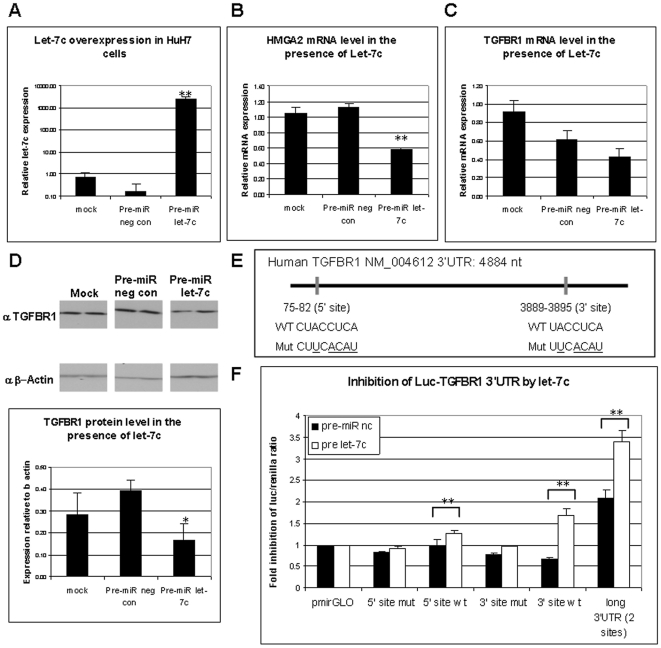
TGFBR1 is a direct target of hsa-let-7c.A. QRT-PCR results of hsa-let-7c expression level in mock transfected HuH7 cells or cells transfected with 30 nM of pre-miR negative control #1 (neg con) or pre-miR let-7c for 48 hrs. B–C. QRT-PCR results of mRNA level of HMGA2 (B) and TGFBR1 (C) in HuH7 cells transfected as described in A. D. Western blot analysis of TGFBR1 protein level in HuH7 cells transfected as described in A for 72 hrs. Quantification of the bands' intensity is shown below. E. Schematic of the 3′UTR of human TGFBR1 with the location and sequence of the 5′ and 3′ putative let-7c binding sites. The 3′UTR fragments that were cloned in pmirGLO are illustrated below. The mutations which were incorporated in the control vectors are underlined below the wt sequences. F. Luciferase/Renilla ratio results for HuH7 cells co-transfected with 7.5 nM of pre-miR negative control (nc) or pre-miR let-7c together with pmirGLO or pmirGLO-TGFBR1 3′UTR 5′ site (wt or mutant) or pGL3-TGFBR1-3′UTR 3′ site (wt or mutant) or pmirGLO-TGFBR1 long genomic 3′UTR (containing both sites), for 72 hrs. Renilla expression from the pmirGLO vector was used for Luc/Renilla ratio quantification. The results are presented as fold-inhibition relative to cells transfected with pmirGLO together with the corresponding pre-miR (nc or let-7c). In all histograms, the average of at least three samples is shown with the SD. * p<0.05, ** p<0.01 in 2-tailed student's t-test when compared to pre-miR neg con.